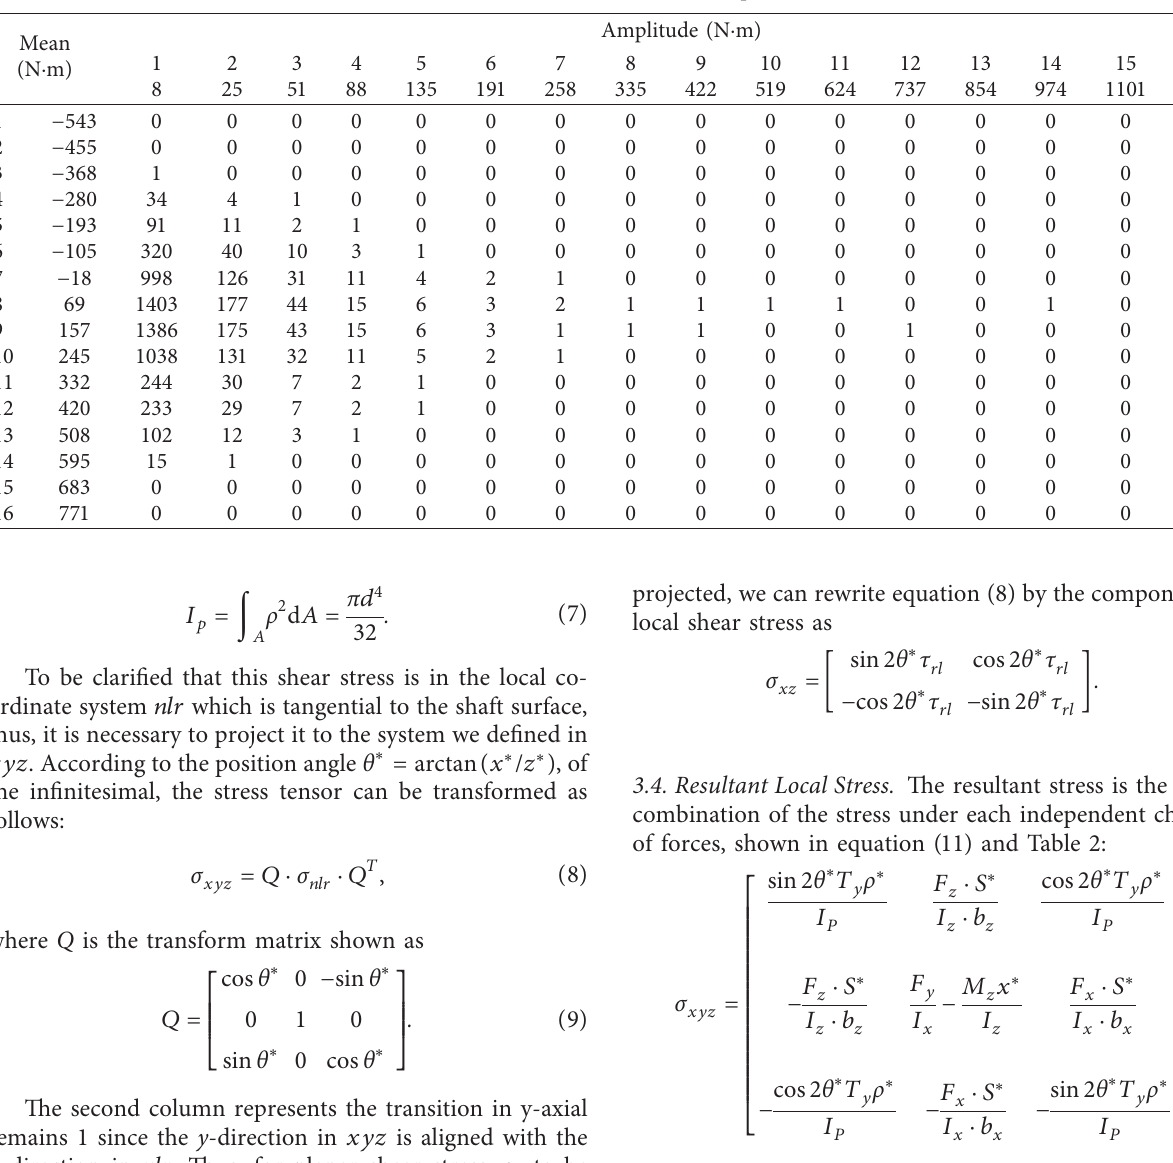
Figure 3: The joint probability density of mean and amplitude values. Table 1: The two-dimensional load